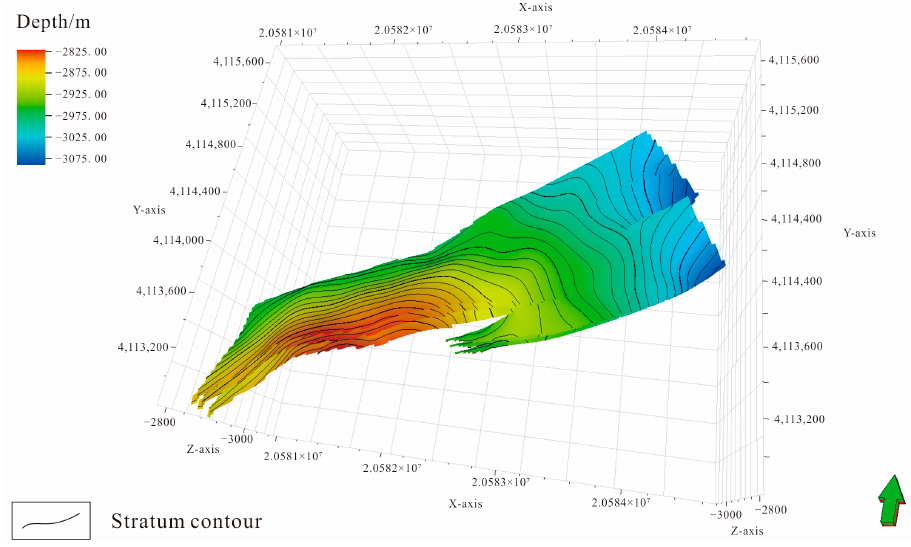
Figure 12. Horizon model of Gao89-1 block.